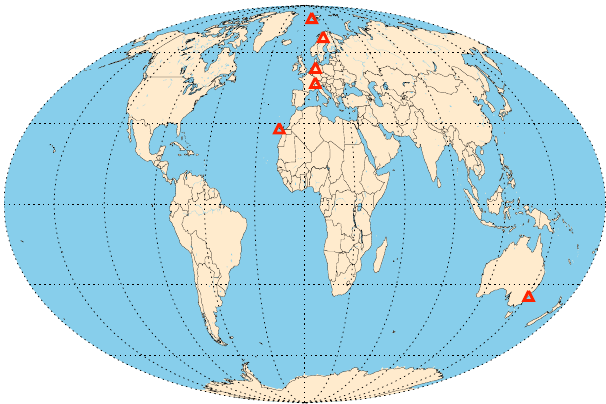
Fig. 1. Ground-based FTIR spectrometer locations used in the com- parisons. From the north to the south, in red: Ny- ˚Alesund, Kiruna, Bremen, Jungfraujoch, Iza˜na, and